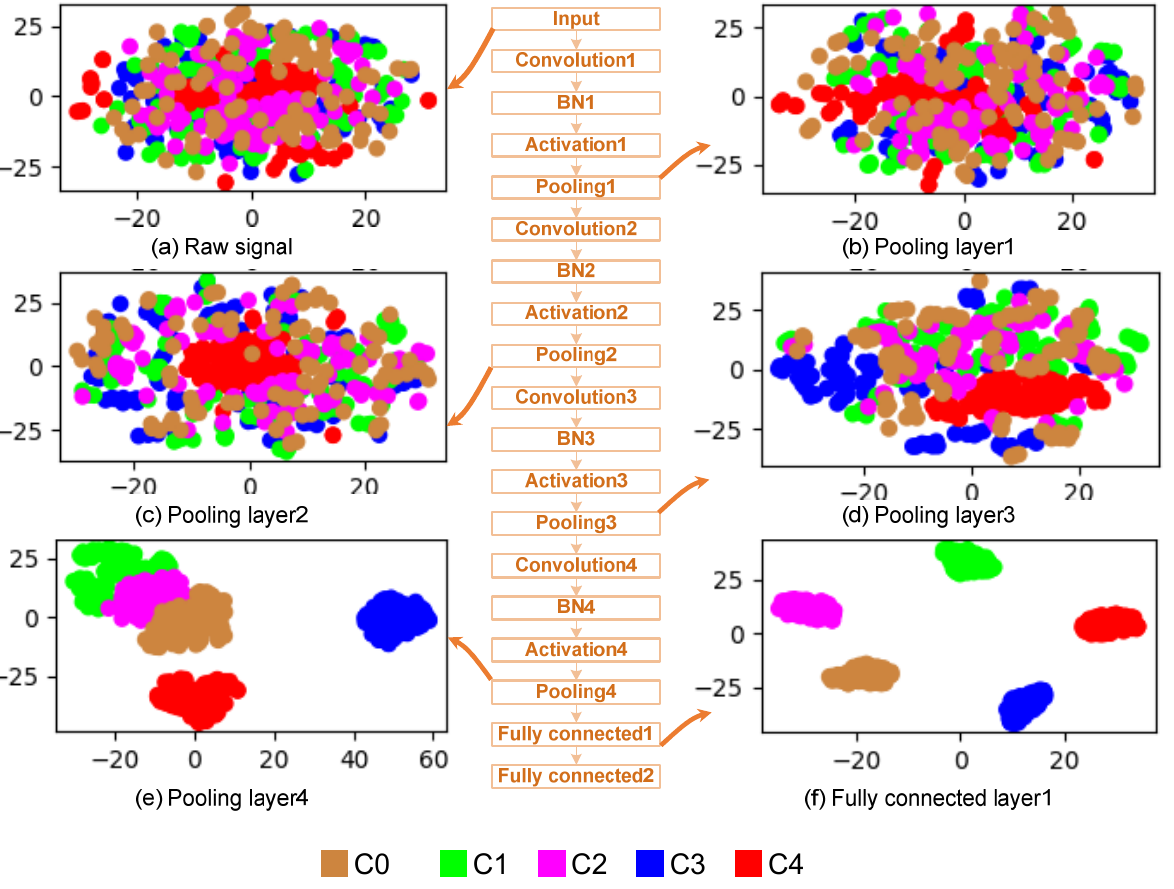
Figure 12. Visualization of features learned in different layers.